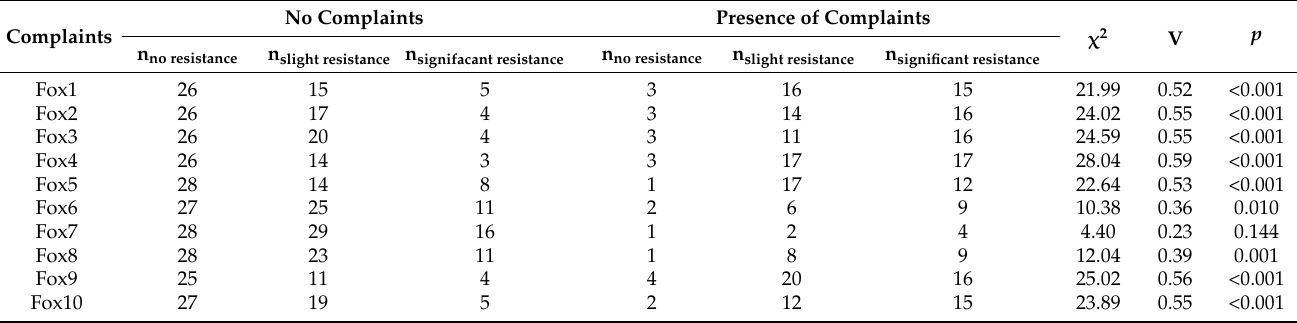
Table 14. Analysis of the relationship between the results of the Fox’s test and the sliding mirror